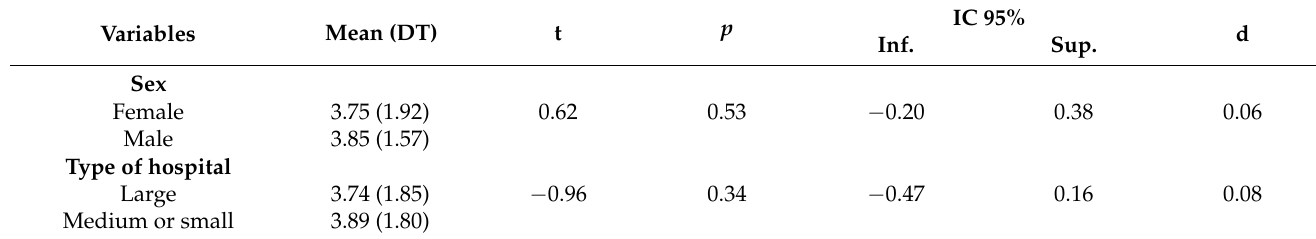
Table 4. Student’s t -test for social lateral